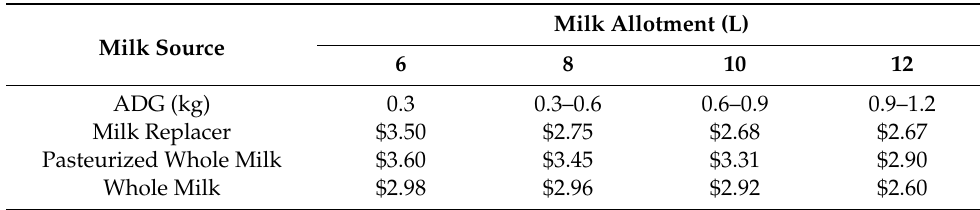
Table 5. Feed cost per kg of gain of pre-weaned calves fed milk replacer, pasteurized whole milk and whole